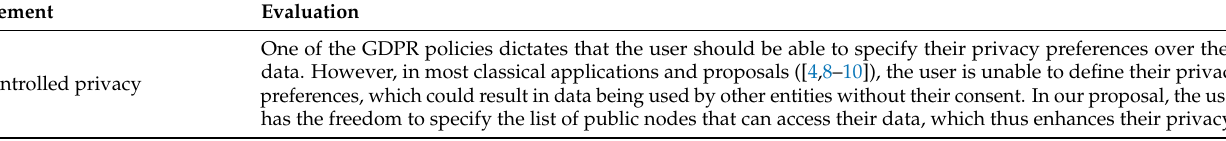
Table 2. Validation of security and privacy